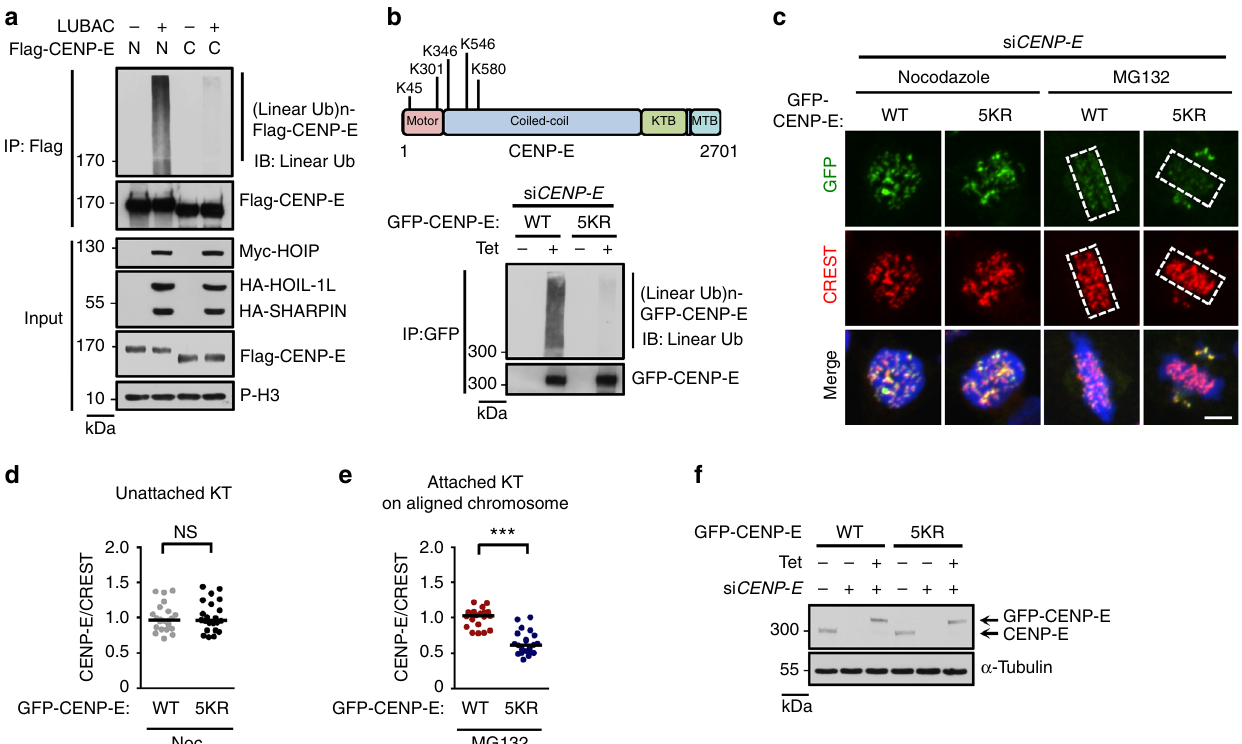
Fig. 5 Linear ubiquitination regulates CENP-E localization on attached kinetochores. a The linear ubiquitination of CENP-E N-terminal (residues 1-1360) and C-terminal (residues 1340-2701) truncations in mitotic HEK293T cells co-transfected with LUBAC. b Top: diagram of CENP-E with identi fi ed fi ve major linear ubiquitination sites. K, lysine. Bottom: Flp-In T-REx HeLa stable cell line expressing Tet-inducible GFP-CENP-E WT/5KR mutant were transfected with CENP-E siRNA, then were synchronized into mitosis and treated with tetracycline to induce GFP-CENP-E WT or 5KR mutant expression. After 36 h, cells lysates were immunoprecipitated by anti-GFP agarose and the immunoprecipitates were analyzed by immunoblotting. KR mutant: in which identi fi ed ubiquitinated lysine (K) sites of CENP-E were substituted with arginines (R). c Kinetochore localization of GFP-CENP-E WT or 5KR mutant in Nocodazole (Noc.) or MG132-arrested Flp-In T-REx HeLa stable cell lines depleted of endogenous CENP-E. Green, GFP-CENP-E; red, CREST; blue, DNA. Dashed boxes, regions of aligned chromosomes. Scale bar, 5 μ m. d , e Quanti fi cation of GFP-CENP-E signals on unattached (Nocodazole treated) ( d , n = 22 cells in each group) or attached (MG132 treated) ( e , n = 20 cells in each group) kinetochores in c . Each dot represents one cell. Bars indicate the median. The average CENP-E/CREST ratio of each group was normalized to control cells. NS not signi fi cant, *** P < 0.001; two-sided Student ’ s t -test. f The knockdown ef fi ciency of endogenous CENP-E and the expression of Tet-inducible GFP-CENP-E WT or 5KR mutant in c –